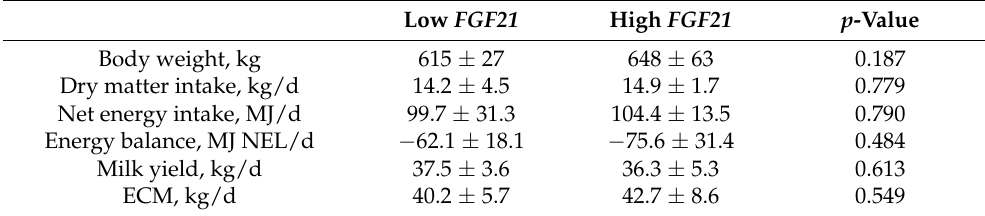
Table 1. Body weights, feed intake, energy balance, and milk performance of cows with high and low hepatic FGF21 expression at days 8–14 postpartum. Low FGF21 High FGF21 p -Value